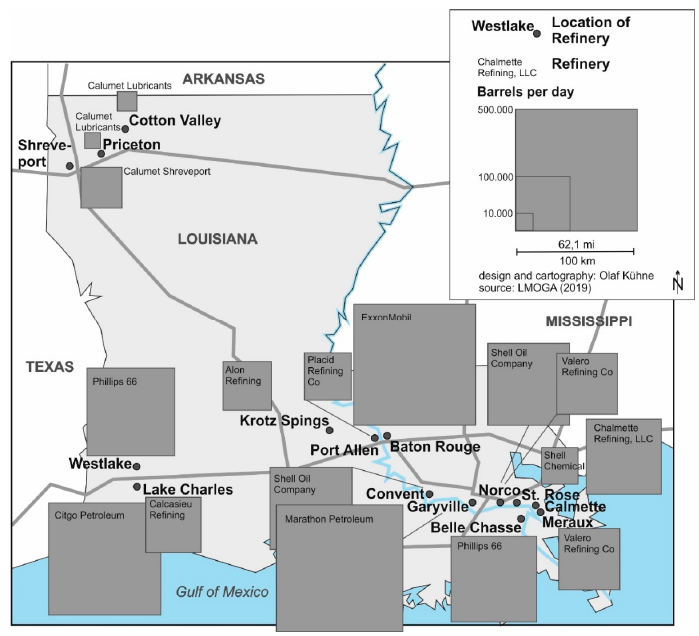
Figure 3. Baton Rouge as the site of the petrochemical industry in southern Louisiana; and daily production of the refineries in Louisiana in January 2017 (own presentation according to [122]).